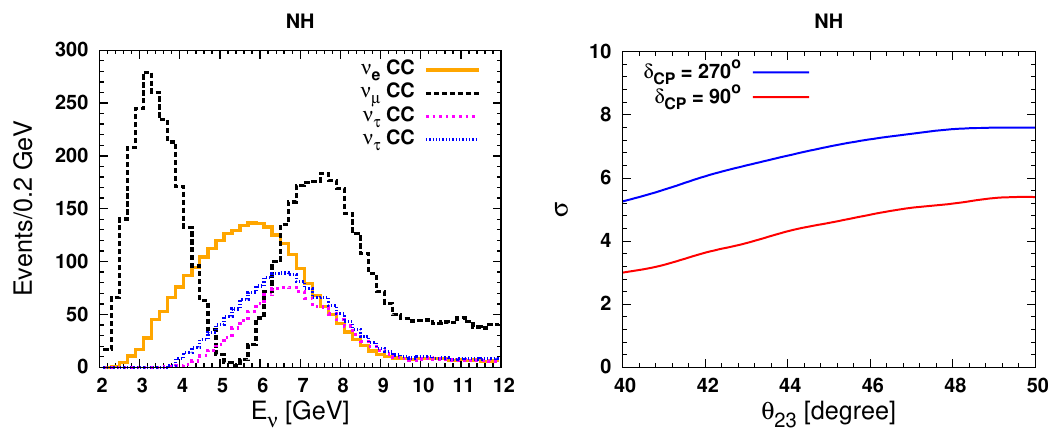
Figure 7 . event spectrum of P2O as a function true energy (left panel) and the hierarchy sensitivity of P2O as a function of θ 23 (right